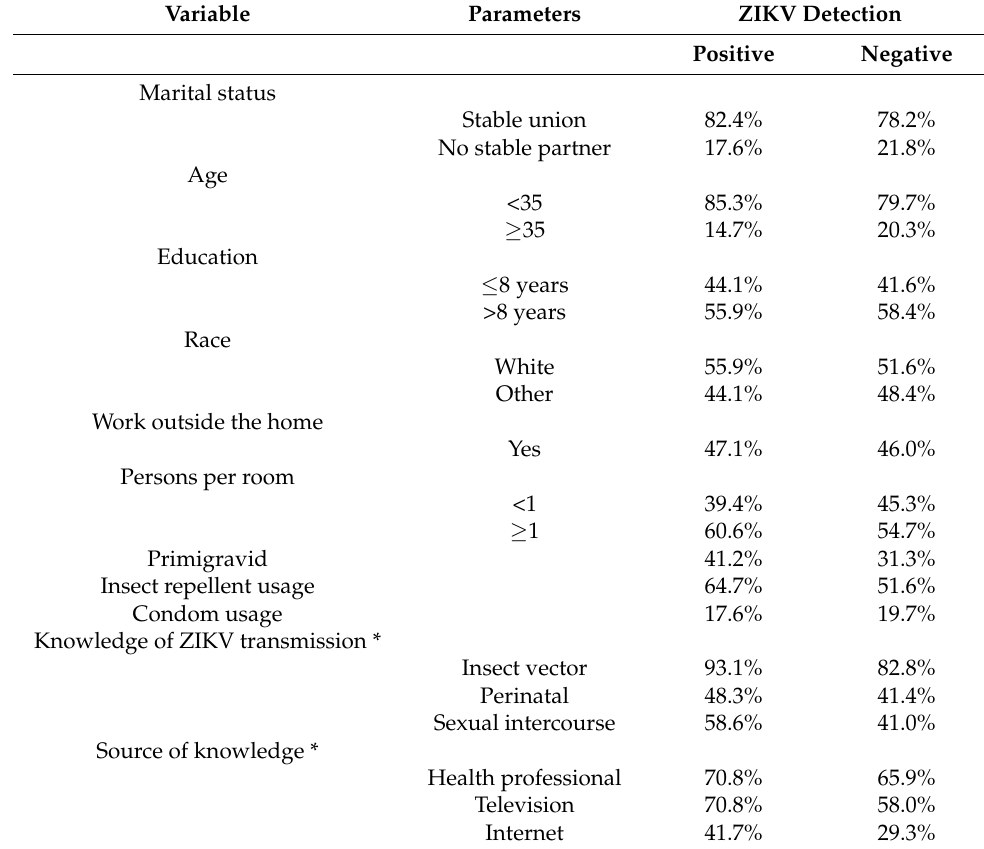
Table 3. Association between variables and ZIKV